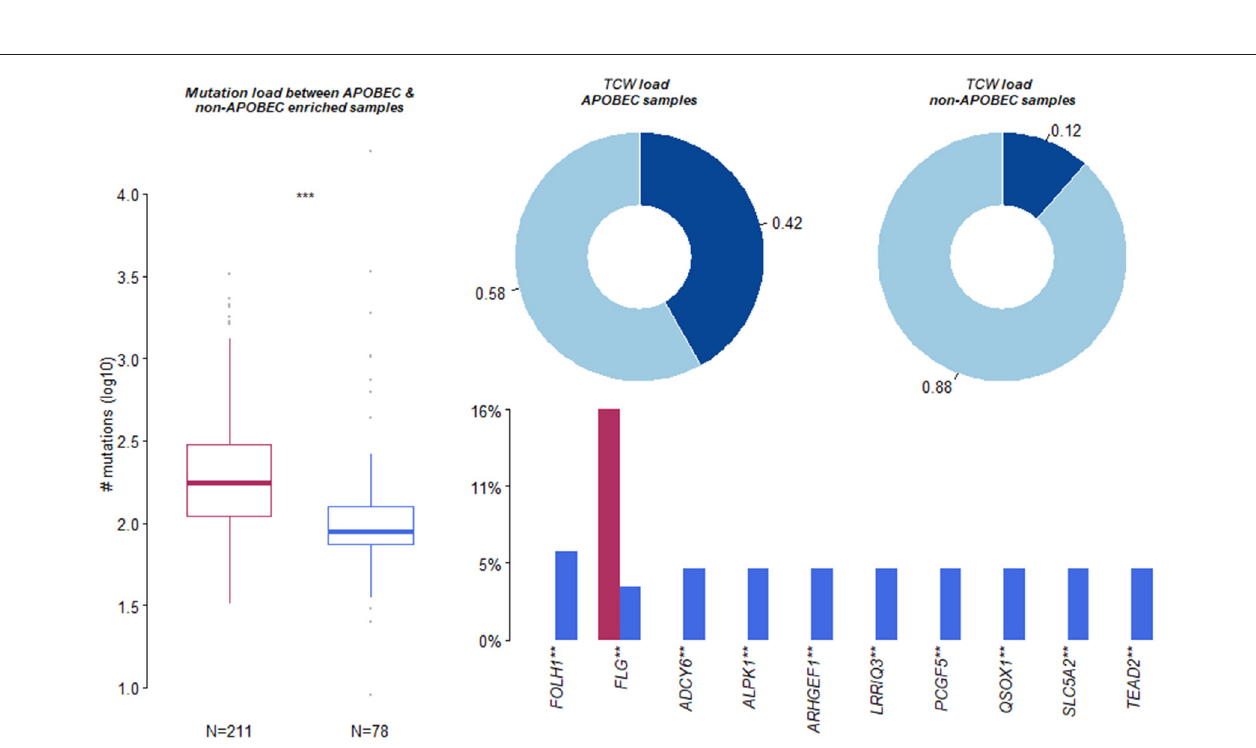
FIGURE 4 | Summary of Apolipoprotein B mRNA editing enzyme-catalyzed polypeptide-like (APOBEC)-induced mutation. Apolipoprotein B mRNA editing enzyme-catalyzed polypeptide-like -enriched and non-enriched sample sizes were 211 and 78, respectively. The top 10 of 192 differentially APOBEC-induced mutant genes were FOLH1, FLG, ADCY6, ALPK1, ARHGEF1, LRRIQ3, PCGF5, QSOX1, SLC5A2, and TEAD2. **, *** means significant difference.